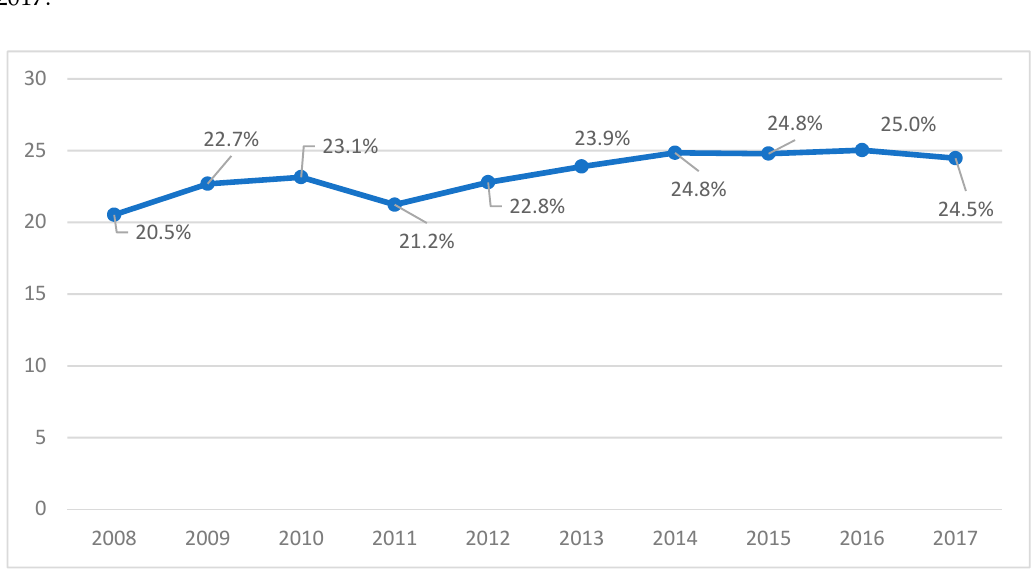
Figure 3. Share (%) of renewable energy in the gross final energy consumption in Romania between 2007 and 2017. Source: Romanian Energy Regulatory Authority (ANRE).